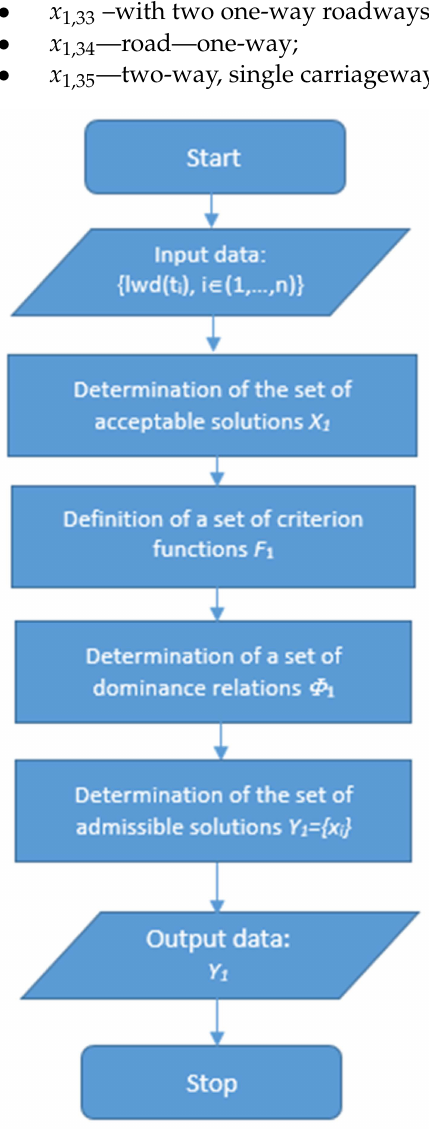
Figure 4. Multi-criteria optimization scheme for determining the optimal set of factors influencing road accidents in